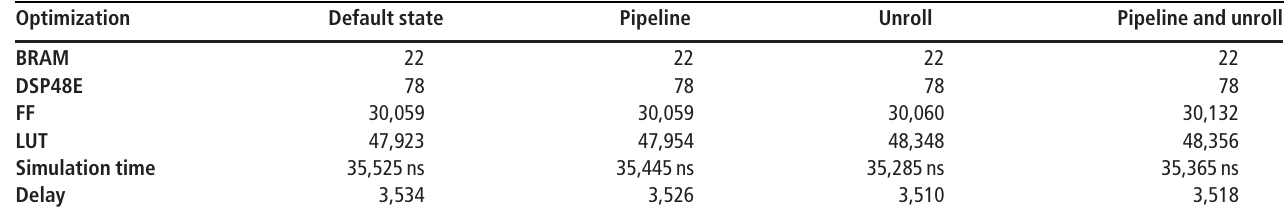
Table 3 Comparison of optimization results Optimization